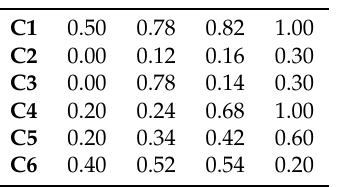
Table 8. Fuzzy weights matrix.